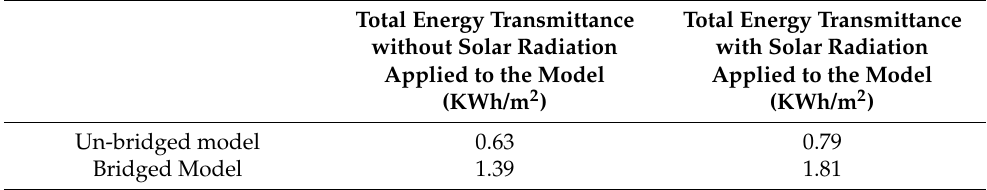
Table 7. Total energy transmitted for the bridged and un-bridged model for the two weeks.